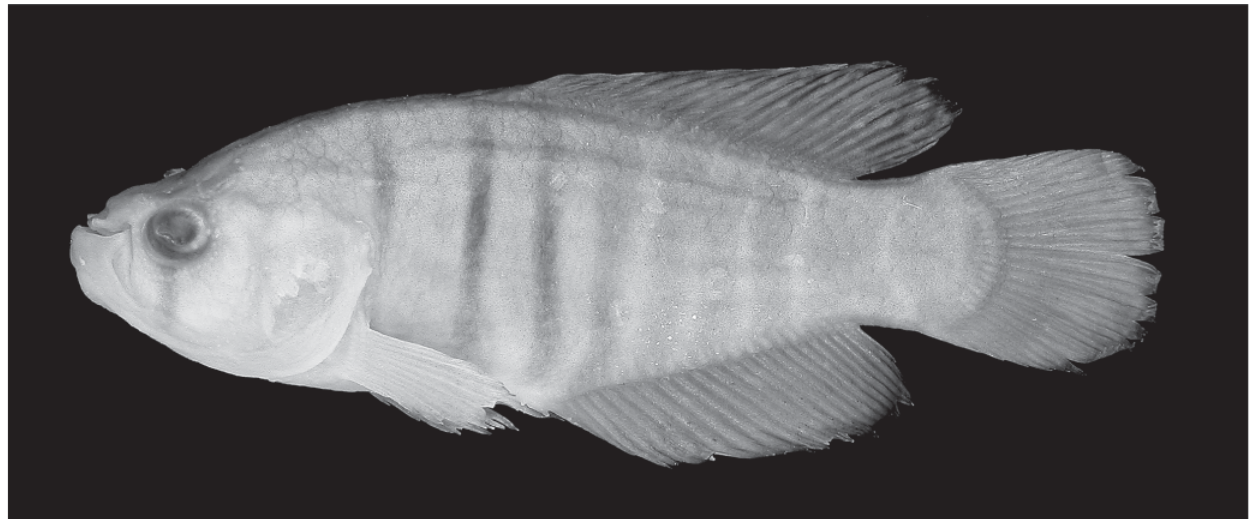
Fig. 1. Austrolebias varzeae , holotype, MCP 29641, male, 33.7 mm SL; temporary lagoon close to the rio da Várzea, rio Uruguay basin, Carazinho, Rio Grande do Sul,